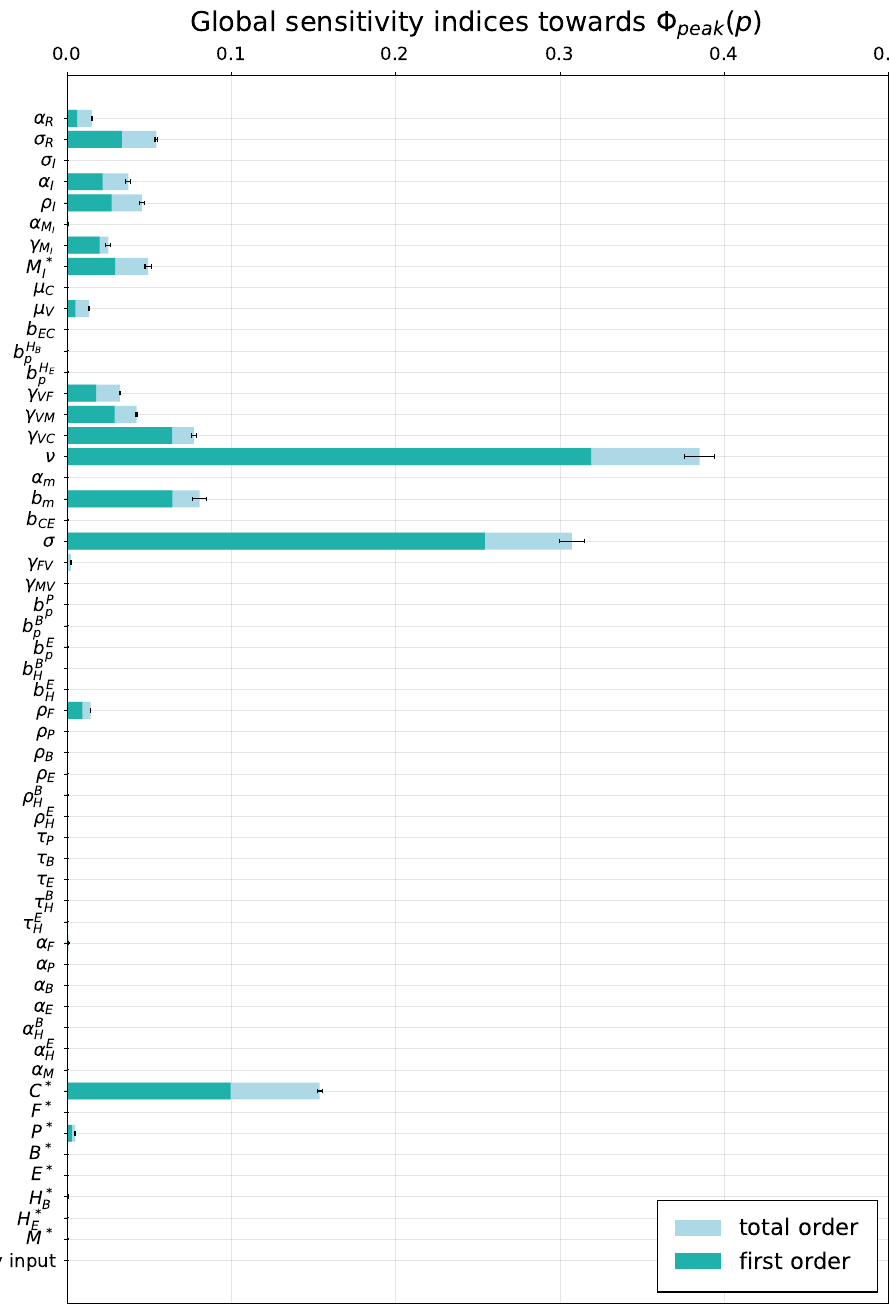
Figure 7. Global sensitivity. Total order- and first order sensitivity indices for viral load peak Φ ( p ) = 5.9 × 10 7 . The errorbars indicating the standard error of the mean over N r = 10 resamples peak are shown for the total-order